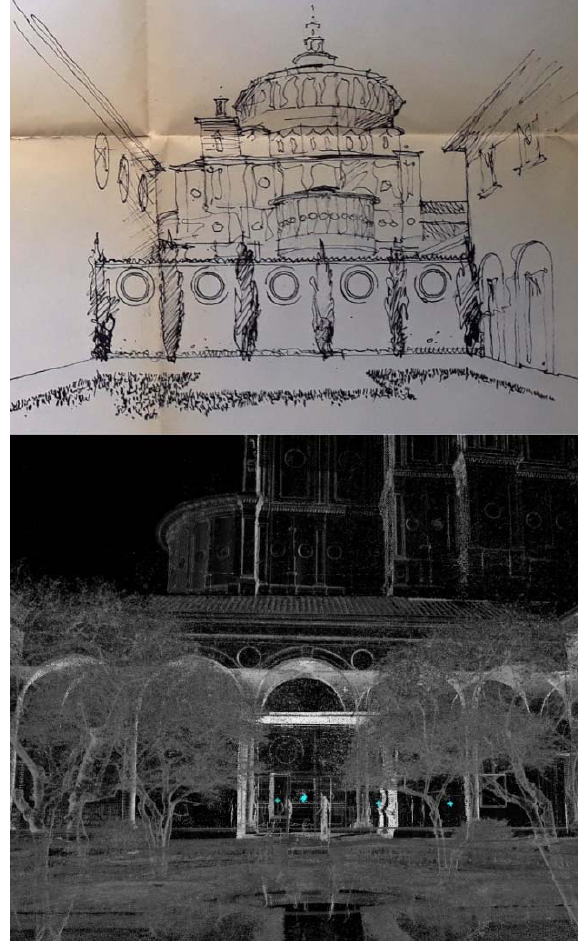
Figure 11. A visual compare between two perspective view: the 3D point cloud and a sketch from a proposed solution of the 50 th from via Sassi with a view on the